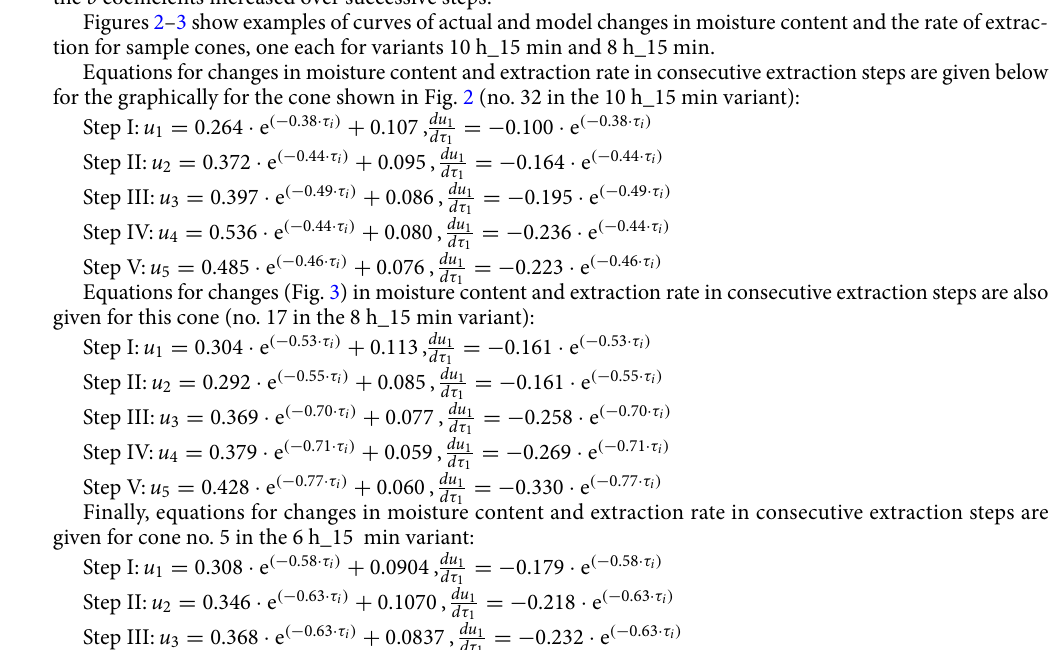
moisture content after step V, which means that their final moisture content was higher than that of cones dried for 8 h and 10 h. The cones with the longest immersion time (15 min) were characterized by the highest initial moisture content in each extraction step as compared to the other two variants (immersion of 5 min and 10 min) with the same drying time. The final moisture content in a given extraction step differed between cones with different immer- sion times. Cones with an immersion time of 15 min were characterized by the highest final moisture content in individual extraction steps, and those with 5 min immersion revealed the lowest final moisture content. The Tukey HSD test revealed homogeneous groups in terms of initial moisture content ( u 01 , u 02 , u 03 , u 04 , u 05 ) and final moisture content ( u k1 , u k2 , u k3 , u k4 , u k5 ) in each step, as shown in Table 4. For instance, four homogene- ous groups were found for the final moisture content after extraction step V ( u k5 ): the first one consisted of all variants except for 7, 8, and 9, the second one included variants 1, 2, 3, and 7, the third one comprised of variants 7 and 8, while the fourth one was constituted by variant 9 alone. Using Eq. (1), changes in moisture content were described for each of the tested cones over all five steps of each variant. The equation included the initial and final values of moisture content and the b coefficient for individual cones. The average values of the b coefficient and standard deviations for each extraction step are presented in Table 5 for individual extraction variants. The lowest value of the b coefficient was recorded for the first step of the 10h_15min variant ( b 1 = 0.34), while the highest value was obtained for the fifth step of the 8 h_15 min variant ( b 5 = 0.60). In the process variants involving 10 and 8 h of drying , the b coefficient increased with each extraction step until the third one; in the fourth step it slightly decreased and in the fifth step it remained constant. In the variants with 6 h of drying the b coefficient almost peaked in the second extraction step and remained at a similar level until the fifth step. In the first steps of the variants with 6 h of drying, the mean value of the b coefficient was 0.54 and did not differ significantly from the coefficients obtained during the other steps. It was noted that in the 8 h_15 min variant, the b coefficients increased over successive steps. Figures 2–3 show examples of curves of actual and model changes in moisture content and the rate of extrac- tion for sample cones, one each for variants 10 h_15 min and 8 h_15 min.